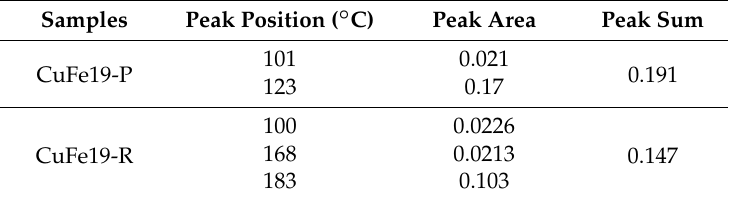
Table 2. Quantitative analysis of s ‐ TPR profiles (second TPR run).